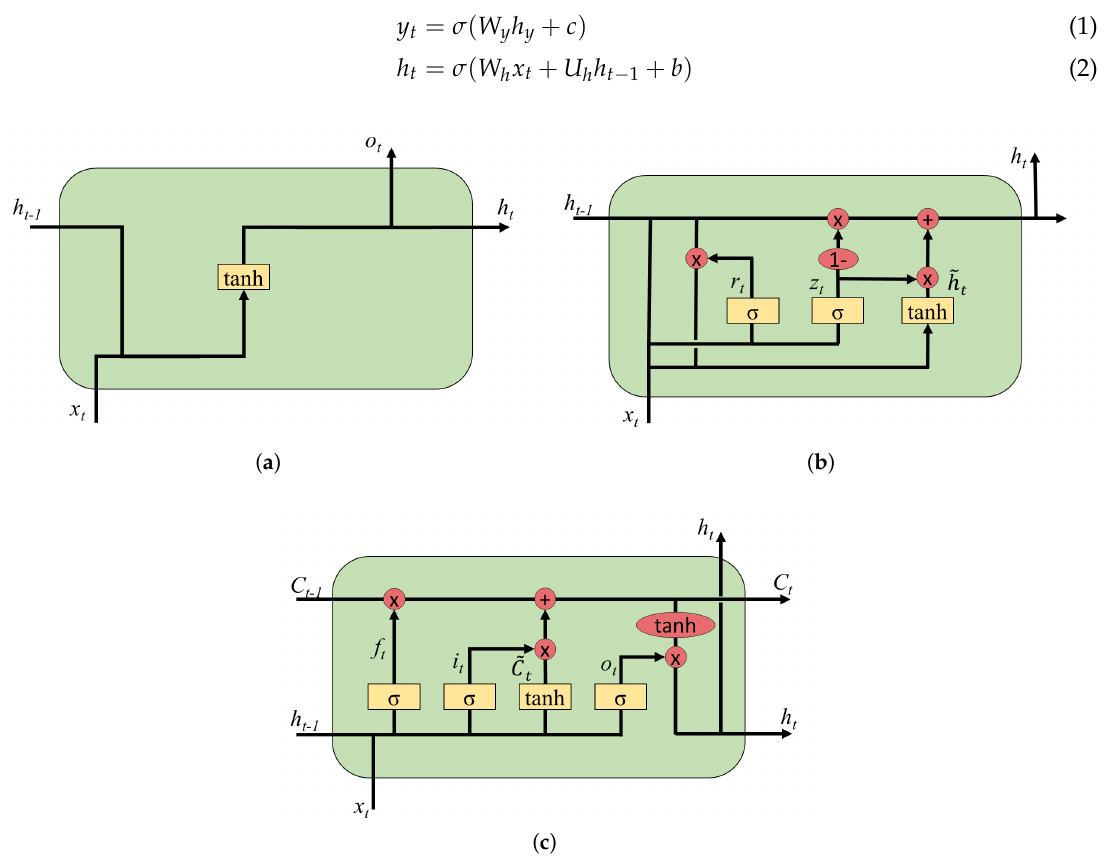
Figure 1. Recurrent neural network architecture structures: ( a ) RNN; ( b ) GRU; and ( c )